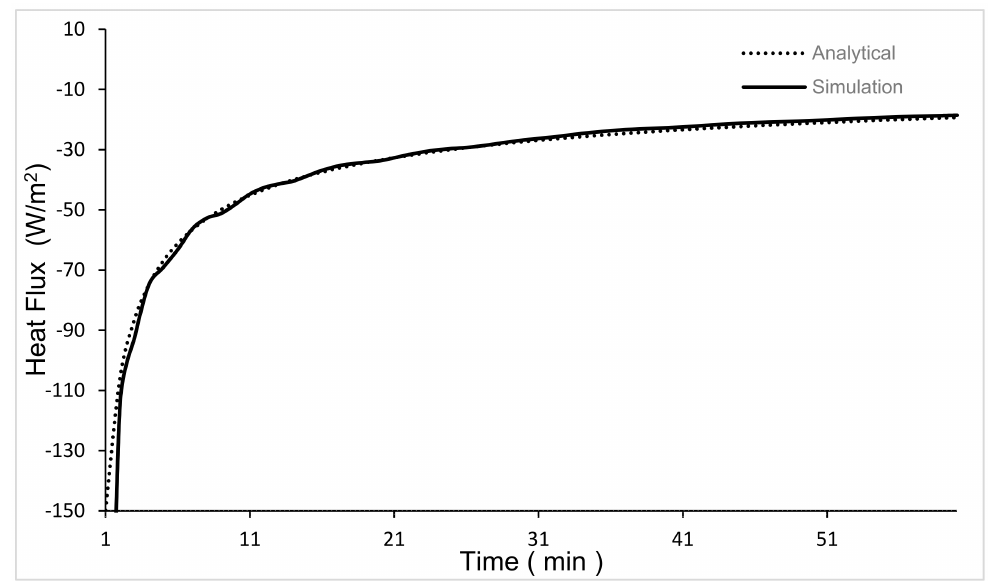
Figure 6. Analytical vs. numerical solution to Stefan’s